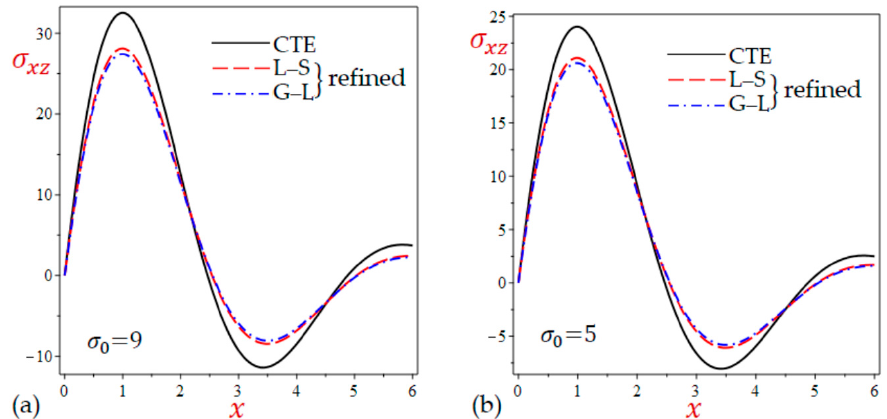
Figure 6. Effect of initial stress σ 0 on the transverse shear stress σ xz of the rotating half-space with